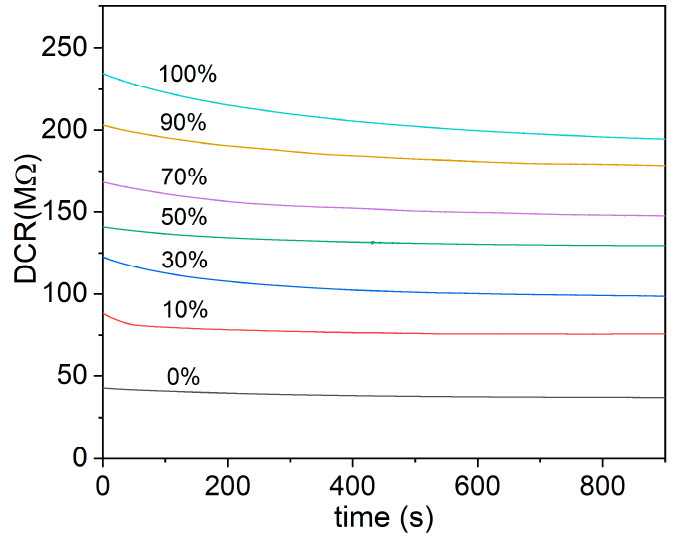
Figure 14. An example of the time monitoring of the resistance at different volumetric concentrations of O 2 for the TiCe-0.8:0.2-100 mixture (this sample is not shown in the Figure 15).